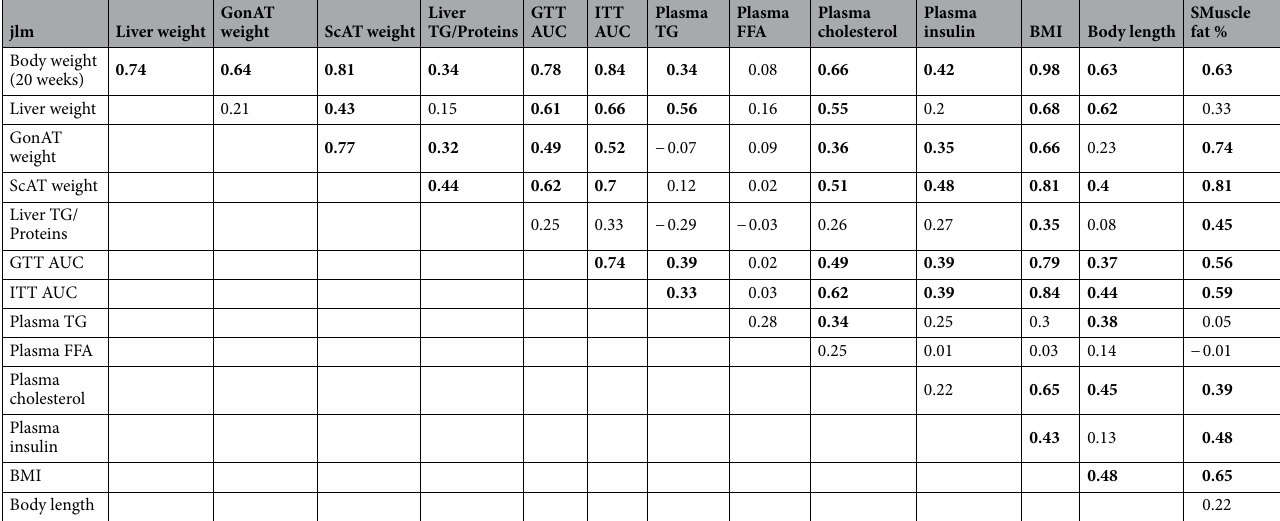
Table 1. Spearman correlation coefficients between the collected phenotypes in the AIL population. Bold indicates significant correlation after multiple testing correction ( p < 9.10E-04). gonAT, gonadal adipose tissue; scAT, subcutaneous adipose tissue; TG, triglycerides; ITT, insulin tolerance test; GTT, glucose tolerance test; AUC, area under the curve; FFA, free fatty acids; BMI, body mass index; SMuscle fat %, skeletal muscle fat percentage.